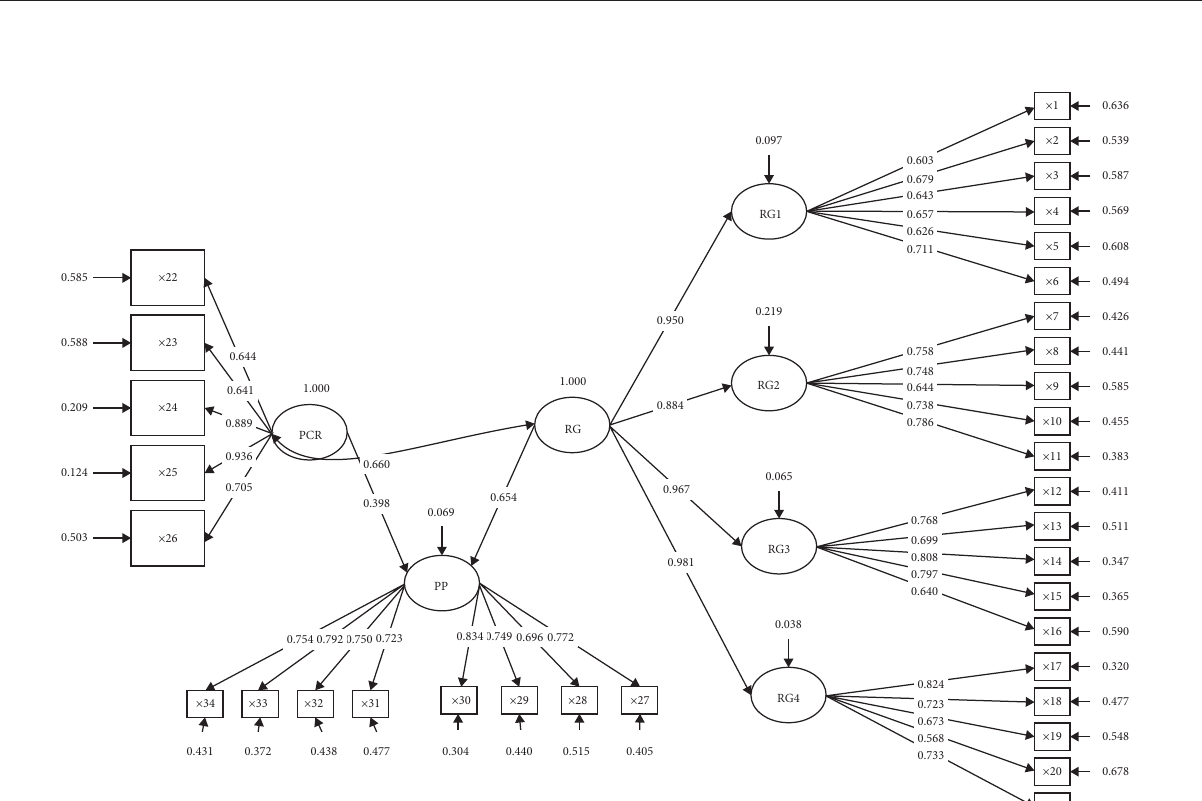
Figure 3: The impact of rule governance and project control on project